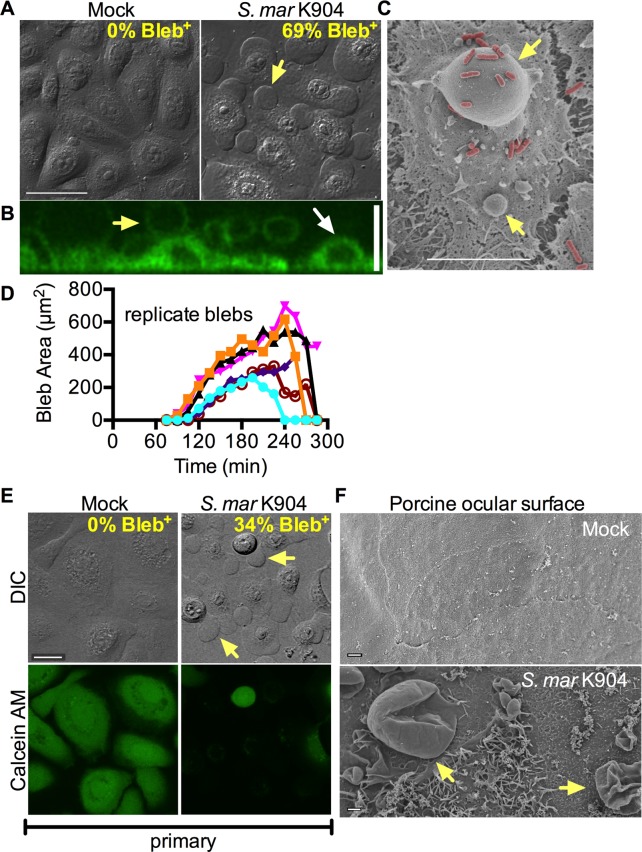
S. marcescens induces blebs and toxicity in human primary corneal cells and on porcine corneal tissue.(A) Confocal differential interference contrast (DIC) micrographs of human corneal cell line (HCLE) challenged with LB medium (mock) or with S. marcescens strain K904 (MOI = 200 for 2 h). Yellow arrows indicate a bleb extending from one of the cells. Size bar indicates 50 μm. (B) Confocal micrograph of HCLE cells challenged with S. marcescens strain K904 for 2 h and stained with a fluorescent membrane dye. The image shows a side projection of a z-stack of images. White arrow indicates a surface attached HCLE cell and the yellow arrow indicates a membrane bleb. Size bar is 20 μm. (C) SEM micrograph of blebs (yellow arrows) on a HCLE cell speckled with pseudocolored S. marcescens K904 bacteria (red). Size bar is 10 μm. (D) 2-D area of arbitrarily chosen blebs from 6 independent experiments tracked with video microscopy. (E) Primary corneal cells imaged by confocal microscopy with DIC and fluorescent imaging of the same cells stained with viability dye Calcein AM. Yellow arrows indicate blebs. Bar = 20 μm. Mock n = 48, K904 n = 22. (F) SEM micrograph of porcine corneas that had been exposed to naïve contact lenses (Mock, top) or contact lenses coated with wild-type S. marcescens (K904, bottom) prior to fixation. Blebs are indicated with yellow arrows.